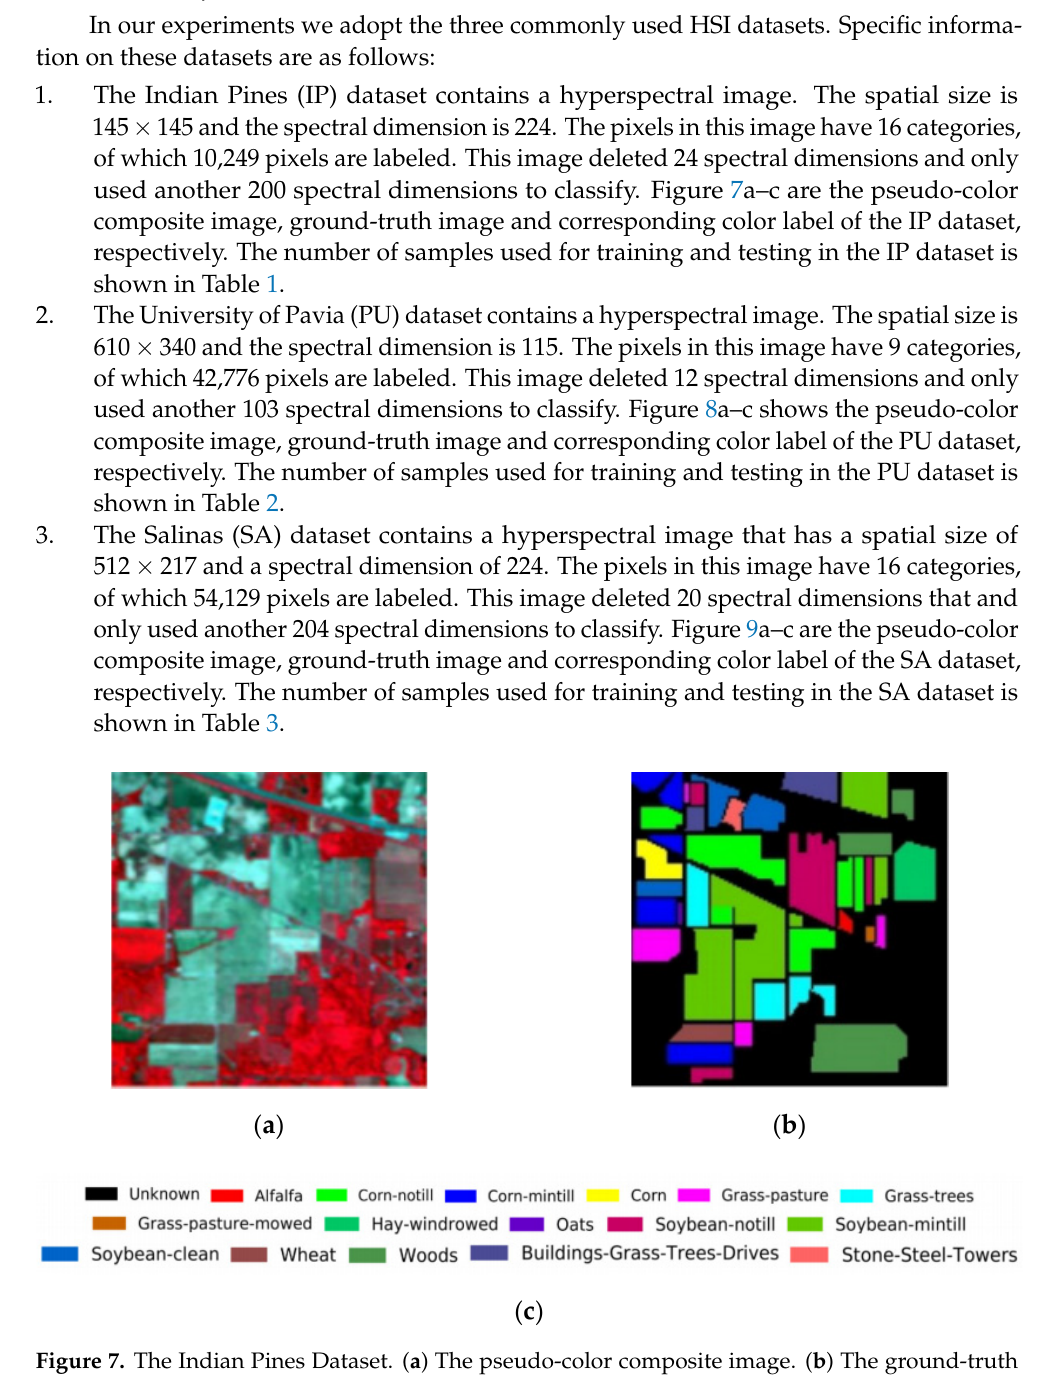
Figure 7. The Indian Pines Dataset. ( a ) The pseudo-color composite image. ( b ) The ground-truth map. ( c ) The corresponding color labels.